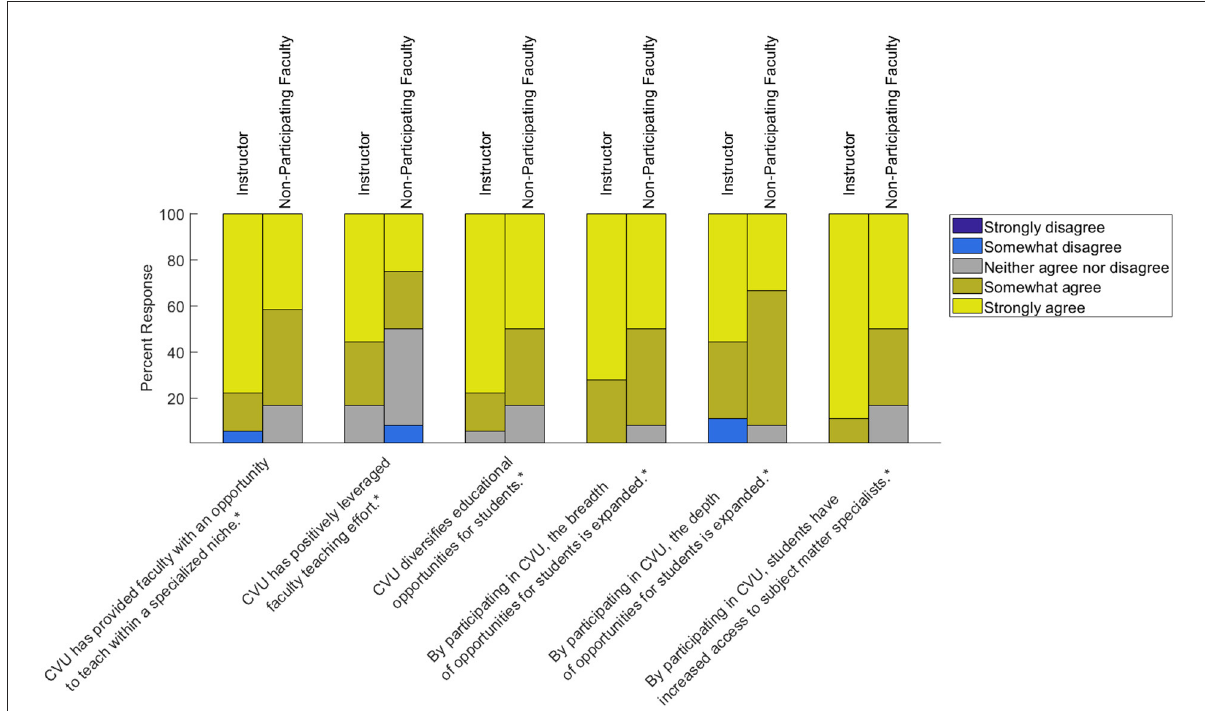
FIGURE2 Levels of agreement to statements about benefits of CVU participation for students and faculty, as perceived by participating instructors and non-participating faculty. The asterisk symbol indicates that there were one or more non-responses to the